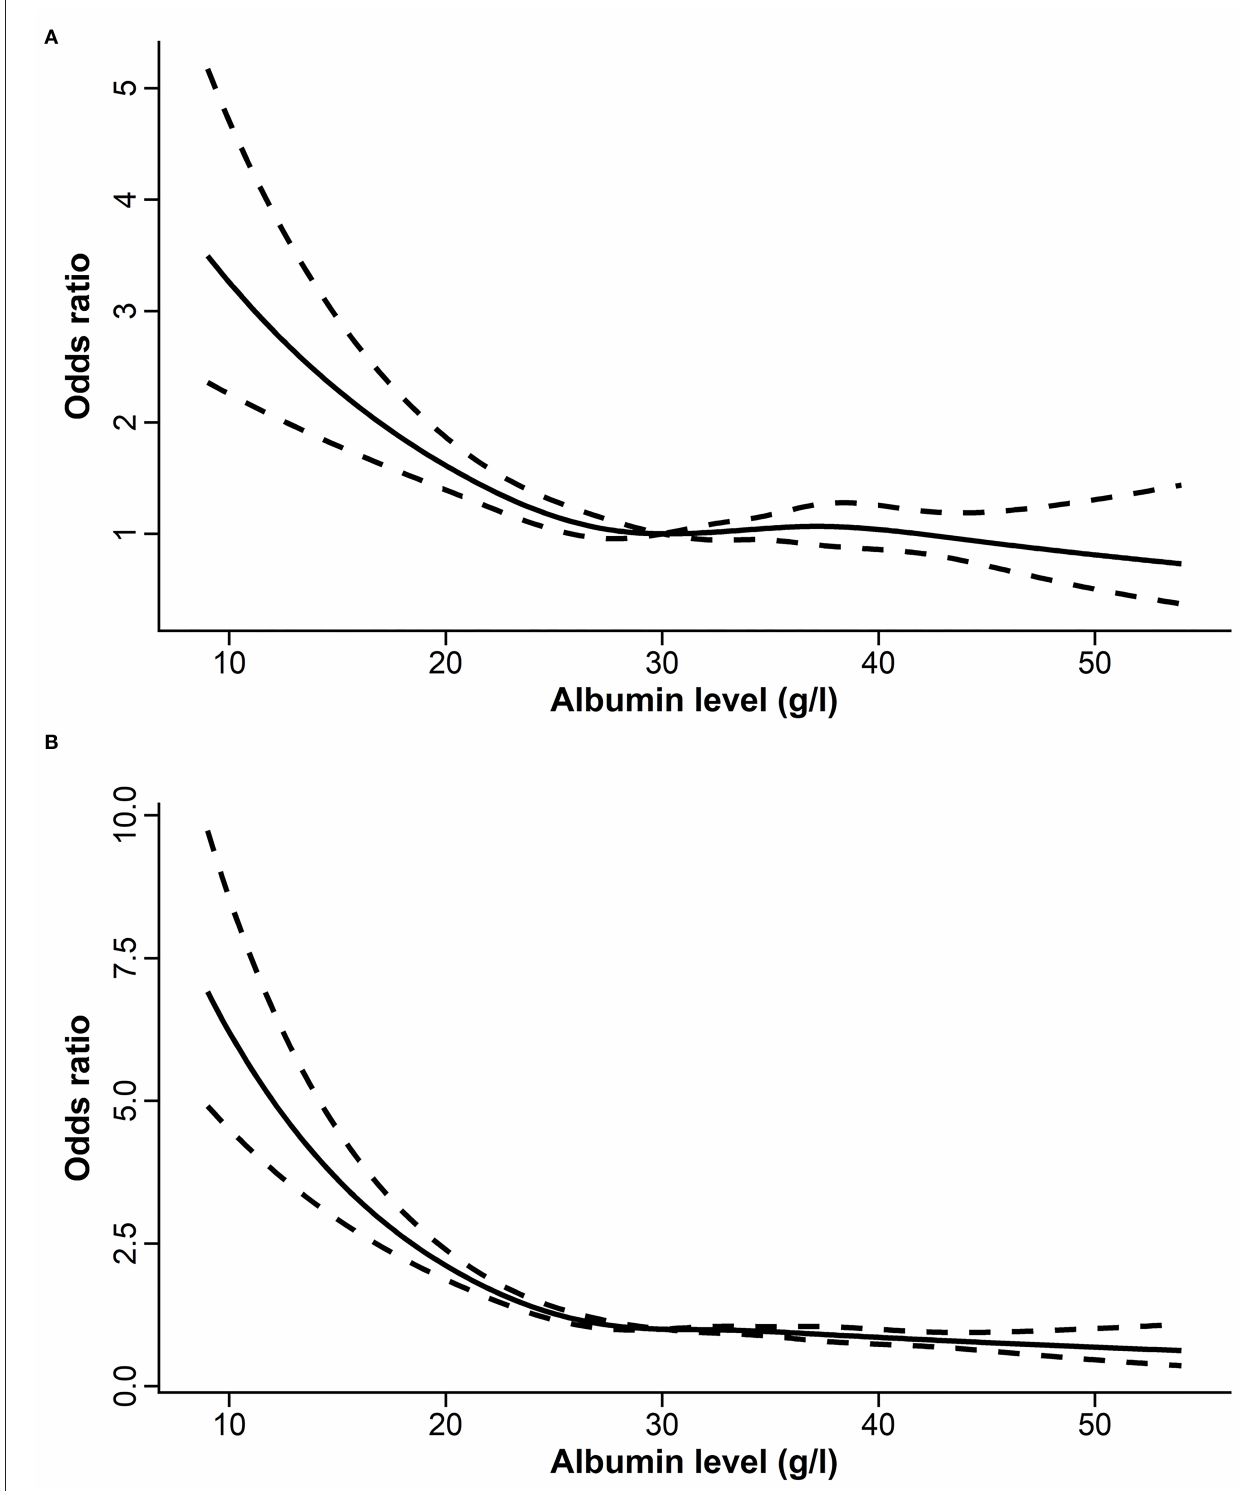
FIGURE 2 | The relationships between serum albumin level and the risk of ICU (A) and hospital (B) mortalities assessed by restricted cubic splines. ICU, intensive care unit.